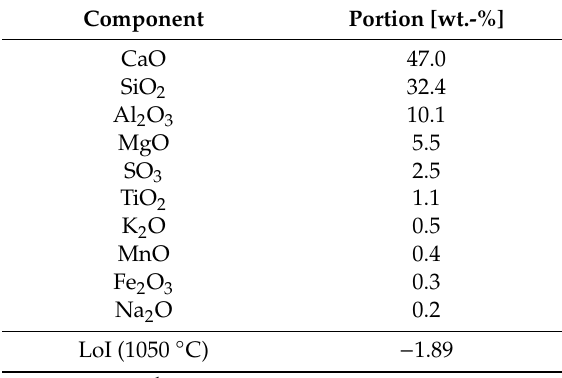
Table 2. Composition of the blast furnace slag used in the corrosion tests 1